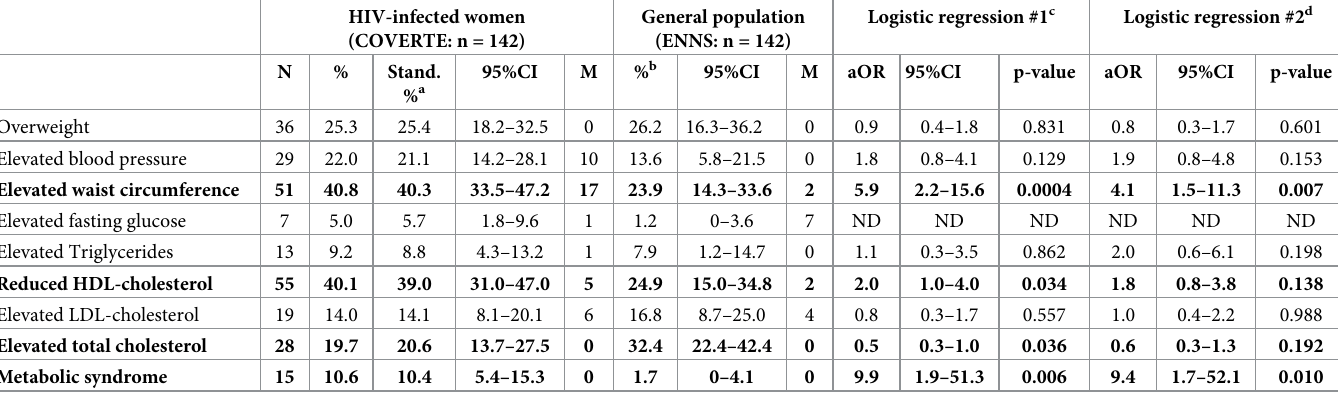
Table 5. Comparison of standardized prevalence of metabolic abnormalities in patients infected with HIV since childhood versus the general population for women (COVERTE and ENNS), adjusted for being overweight and education level, by logistic